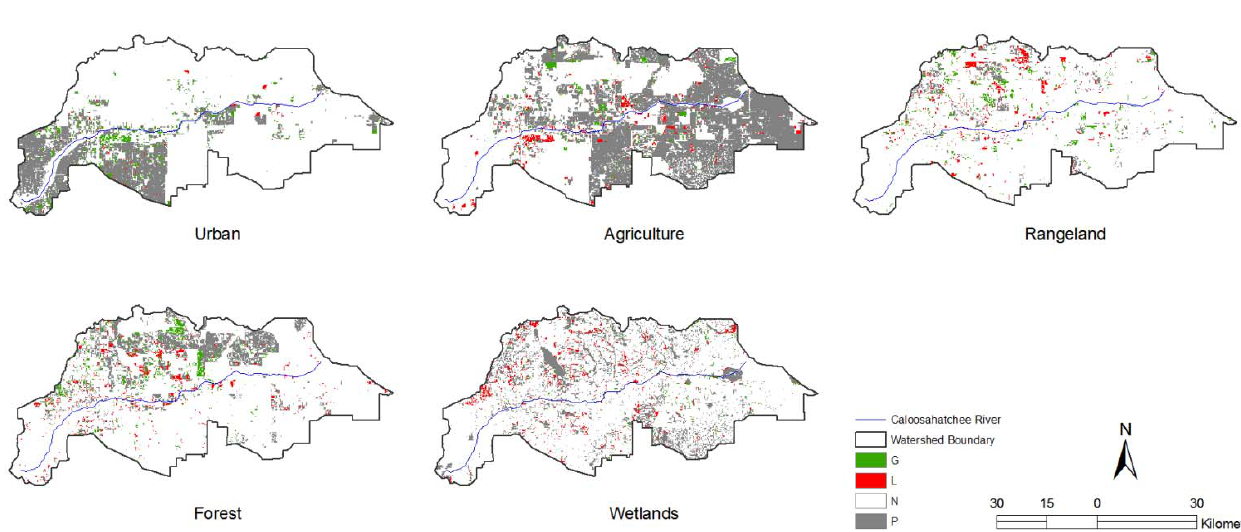
Figure 4. Gains (G), losses (L) and persistence (P) of land uses in the Caloosahatchee River Watershed between 1999 and 2008, based on existing data. Areas not in the land use concerned are represented as